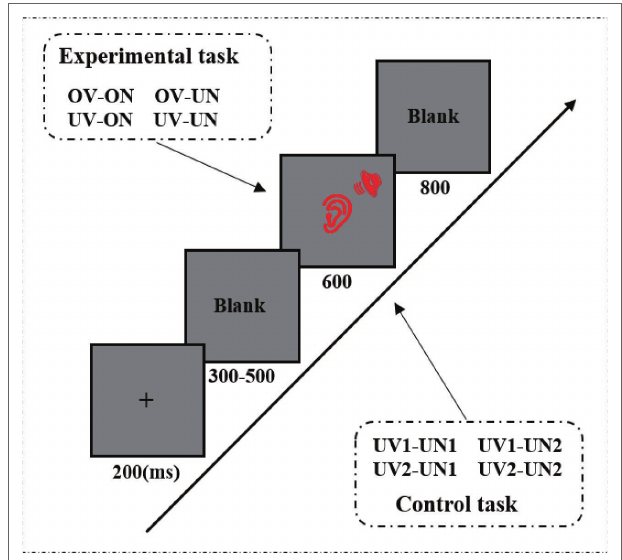
FIGURE 1 | An illustration of the oddball paradigm sequence in a single trial (including experimental task and control task). The only difference between experimental task and control task is that the rare and task-irrelevant stimuli. The experimental task used the ov-on, ov-un, uv-on, and uv-un as task-irrelevant stimuli, but the control task adopted the uv1-un1, uv1-un2, uv2-un1, and uv2-un2 as task-irrelevant